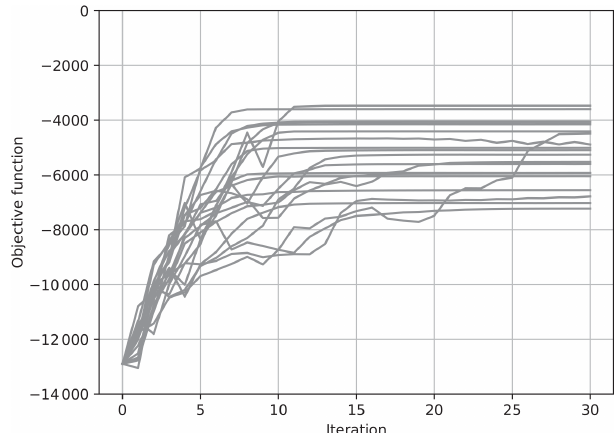
Figure 1. The value of the objective function J for each iteration for 20 trials of the estimation. The ensemble was updated using Eq. (32) with δ = 1 . 5 × 10 − 3 .